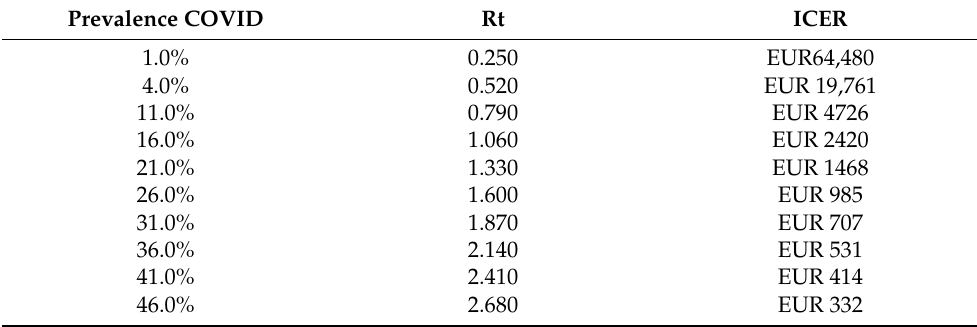
Table 4. Two-way sensitivity analysis primary outcome (infections avoided).